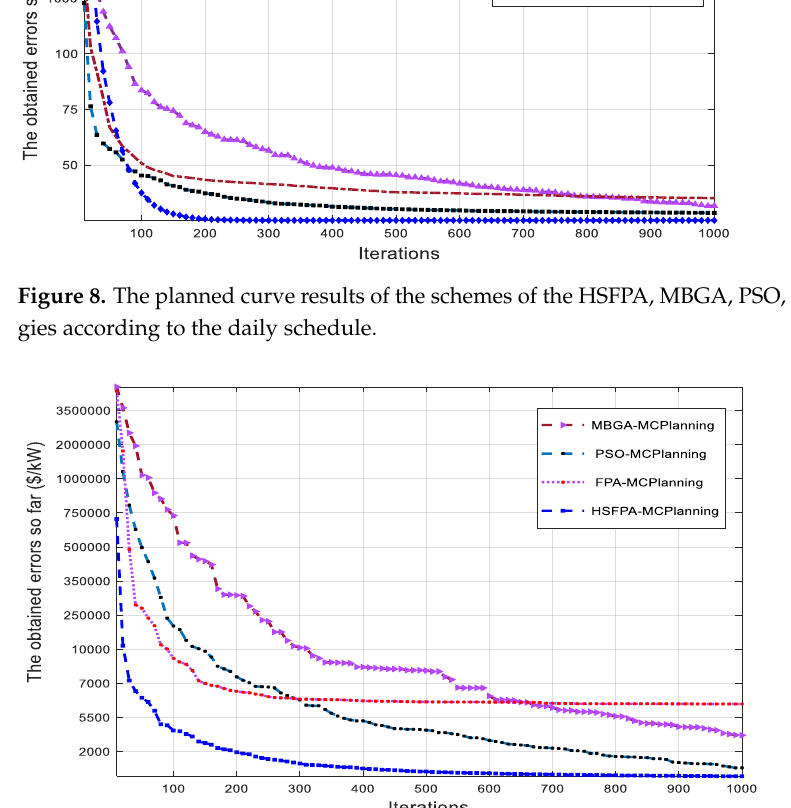
Figure 10. A microgrid ’ s typical daily recourse load outputs.